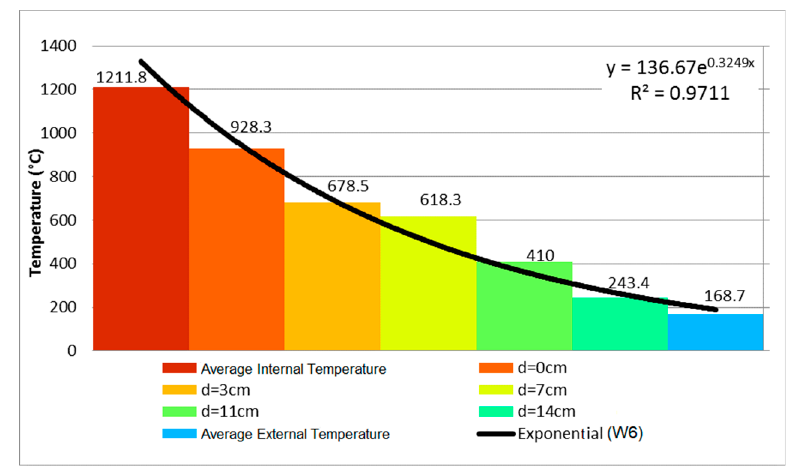
Figure 19. Temperature profile at 240 min—P6.